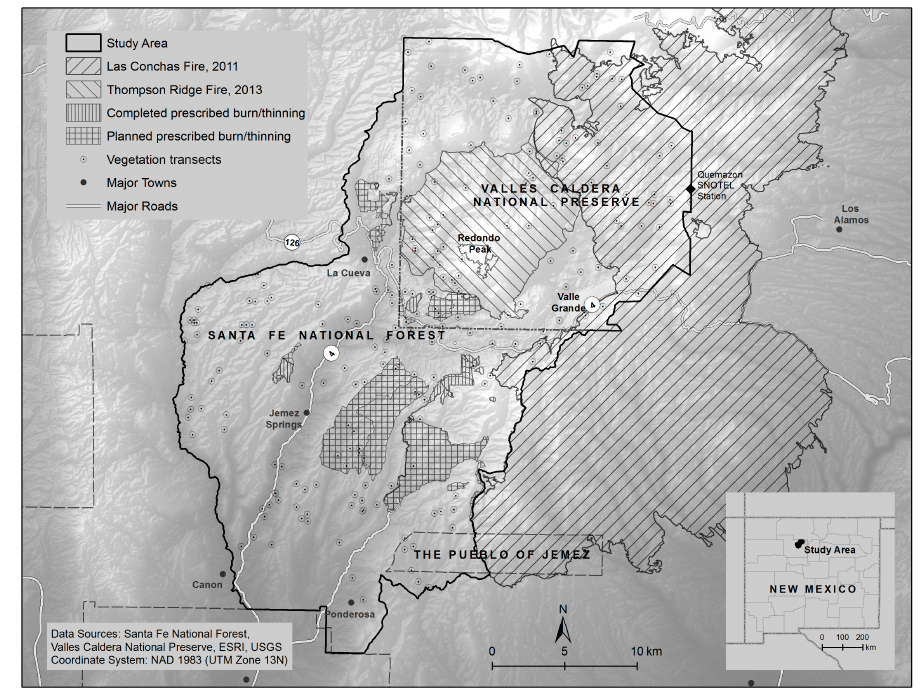
Figure 1. Study area of the Southwest Jemez Mountains (Sandoval Co., NM, USA) showing major wildfires, treated areas as of 2014, planned areas for treatment, and distribution of sampling transects.